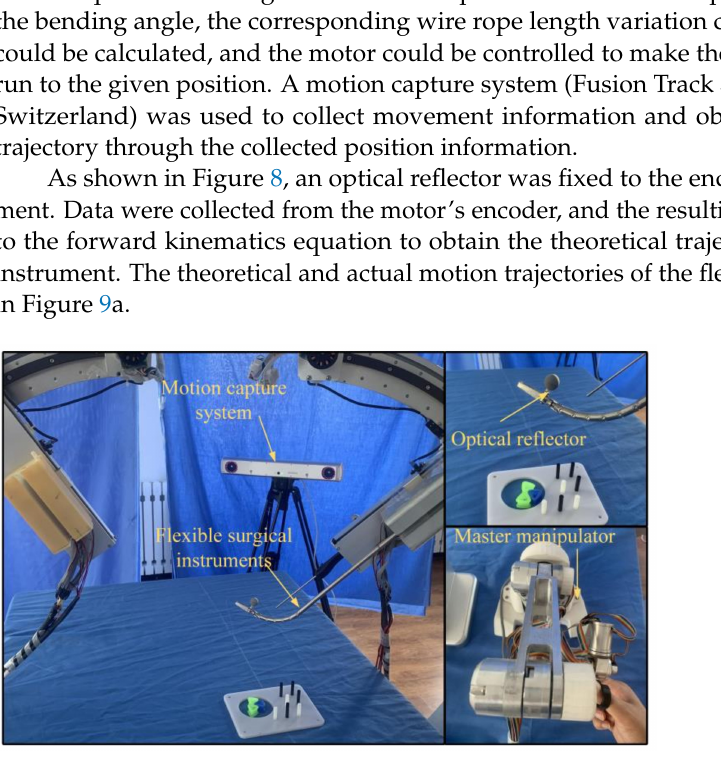
Figure 8. Actual trajectory measurement of the flexible